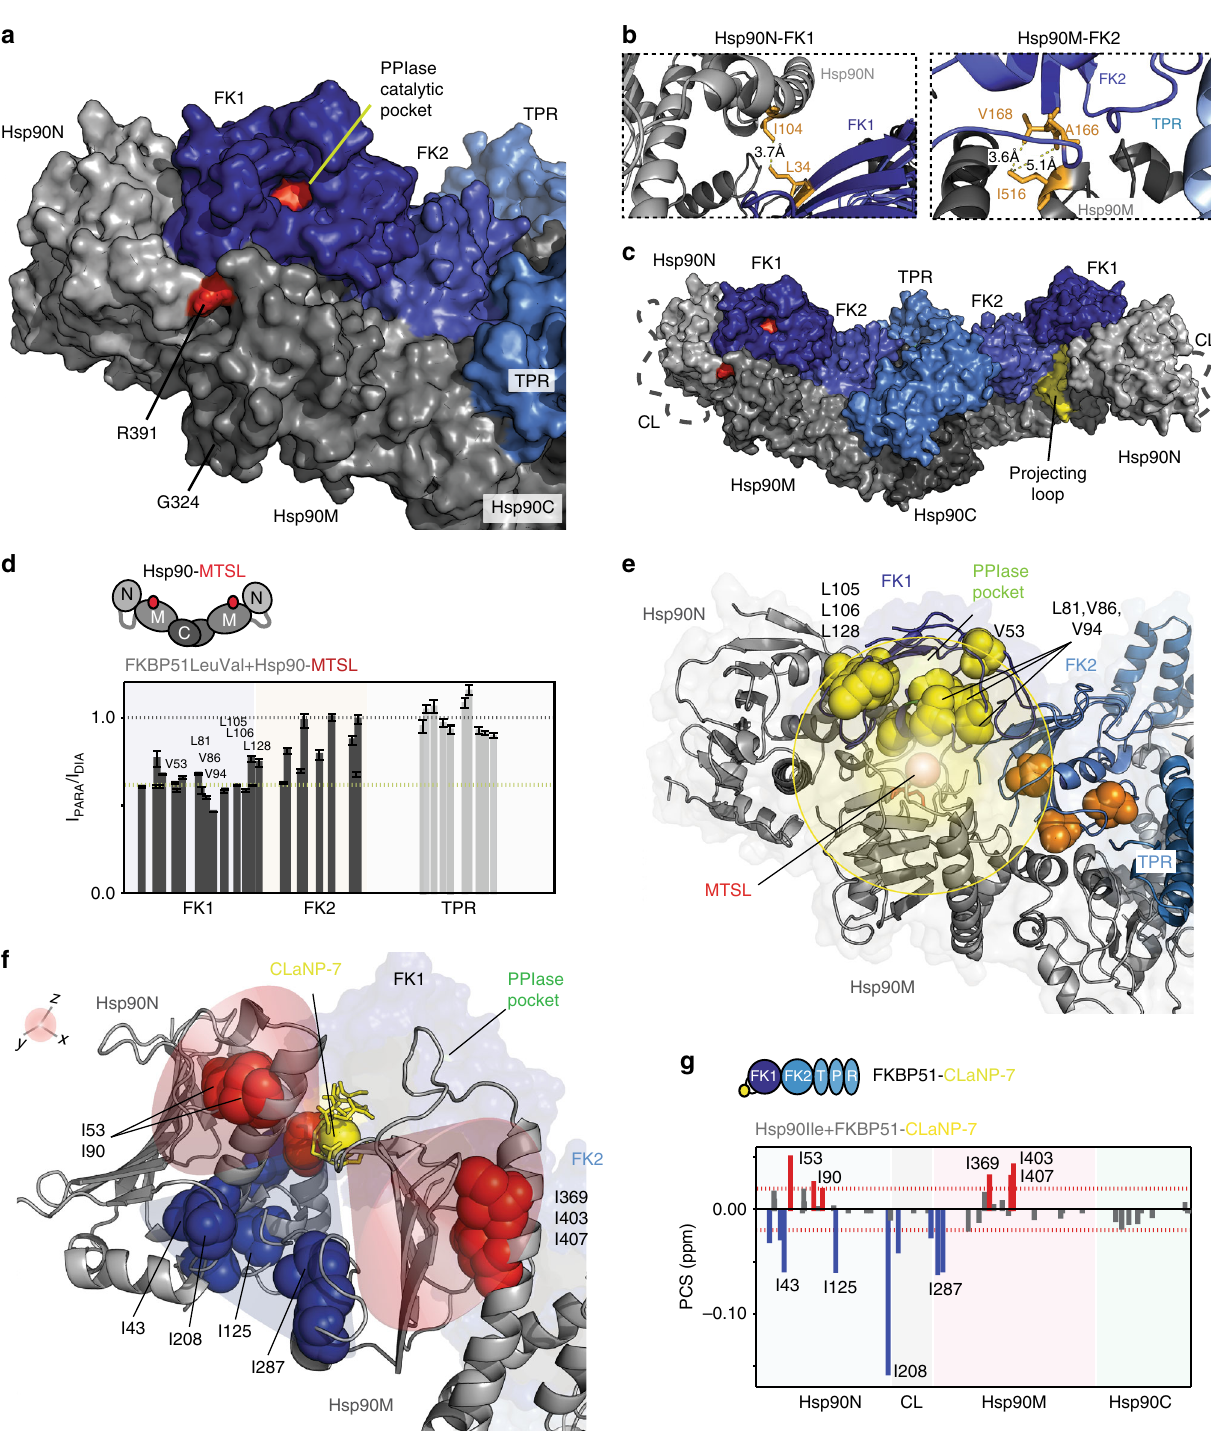
Fig. 3 Head-to-head topology of the 280 kDa Hsp90/FKBP51 complex. a – c Structural model of the Hsp90/FKBP51 complex derived from a combination of structural and biochemical data. Hsp90 is colored gray, and FKBP51 in blue. Insets in b show intermolecular contacts, for which Hsp90/FKBP51-speci fi c NOEs were detected. R391 (red) is critical for Hsp90's ATPase activity. The charged linker (CL) is represented as a gray dotted line in c , and Hsp90M's projecting loop is colored yellow. d PRE-induced signal broadening of FKBP51 moieties upon binding to Hsp90 tagged with MTSL at position 362. Intensity ratios for TPR cross-peaks are shown for comparison (gray), but were not sequence speci fi cally assigned (i.e., placed at random positions in the plot within the MEEVD-binding region). Error bars were calculated based on NMR signal-to-noise ratio. Threshold (yellow line) was set to 0.6. e FKBP51 residues undergoing strongest PREs (below threshold in d ) are represented in yellow spheres and are located in FK1 within 25 Å to the MTSL spin center, validating the structural model. Orange spheres mark FK2 residues with close-to-threshold PRE broadening ( d ). f , g PCSs experienced by Hsp90 moieties upon binding to FKBP51, which was labeled with a single CLaNP-7 lanthanide tag on FK1 (at positions C107 – C110). The orientation of the lanthanide tensor (red and blue shadows in f ) fi ts well with the experimental signs of PCSs (in red and blue spheres in f and bars in g ). Red dotted lines in g represent 1.5 times the SD of the averaged chemical shift changes and are used as a